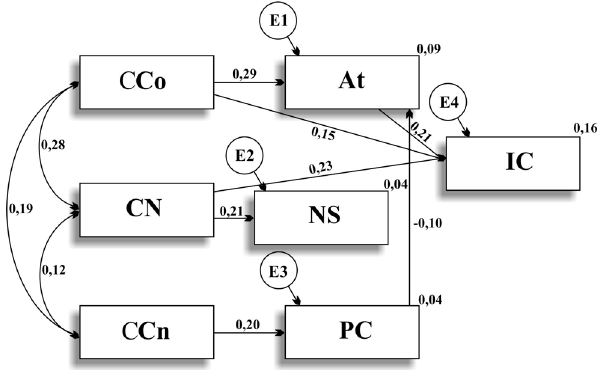
Figura 2. Modelo das relações entre a Atitude (At), Crença Comportamental (CCo), Norma Subjetiva (NS), Crença Normativa (CN), Percepção de Controle (PC), Crença de Con- trole (CCn) e a Intenção Comportamental (IC) para os beneficiários dos Grupos A e B Nota. [ χ 2 /gl = 1,82; GFI = 0,98; RMR = 0,05; RMSEA = 0,05 ( IC = 0,02 e 0,08); CFI = 90